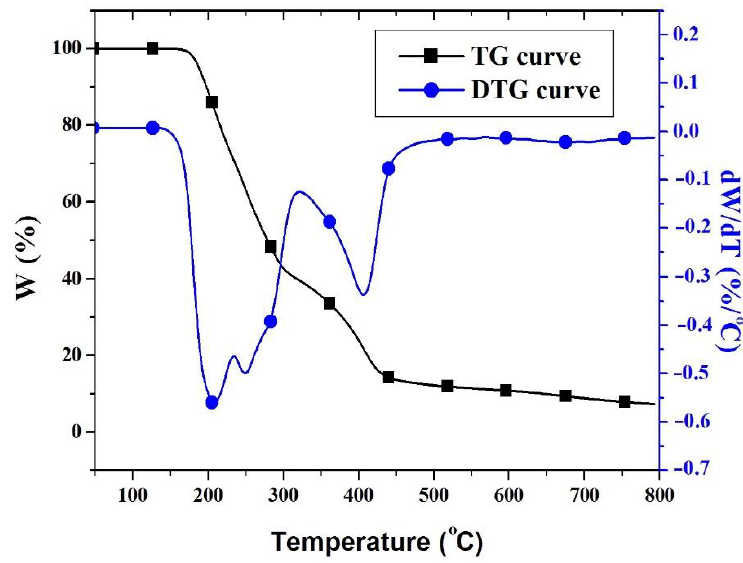
Figure 3. TG and DTG curves of PFR.